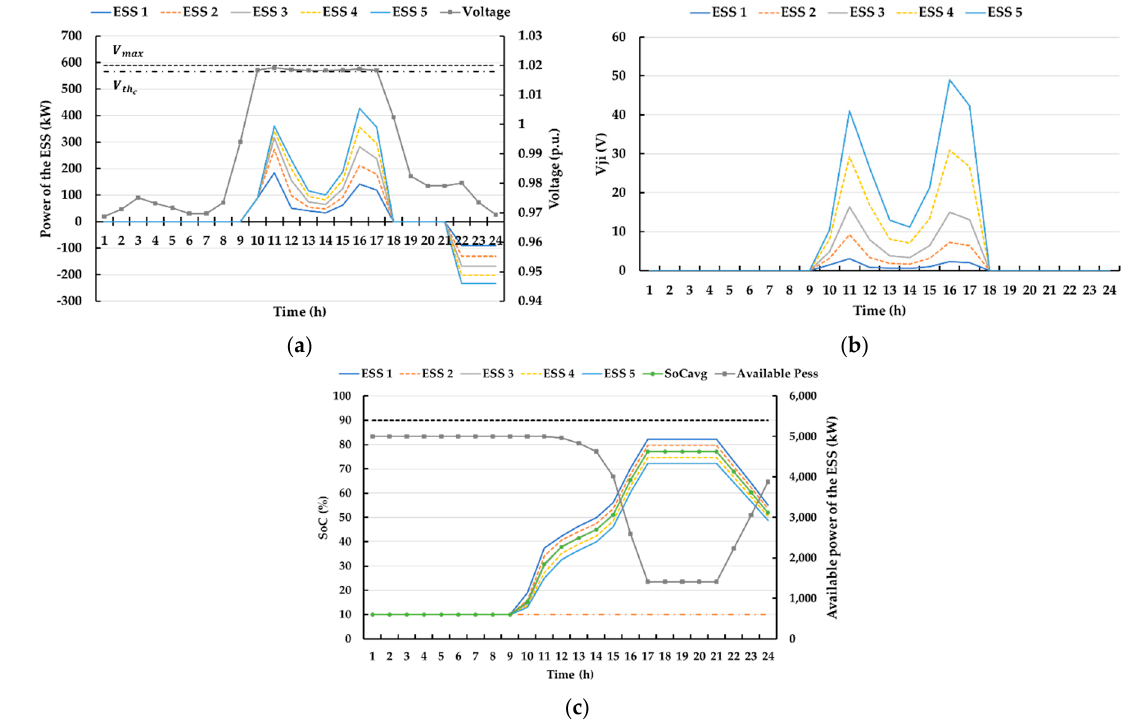
Figure 15. Voltage control results with ε , µ : ( a ) Voltage profile and power of the distributed ESS; ( b ) V t ; ( c ) SoC profile.